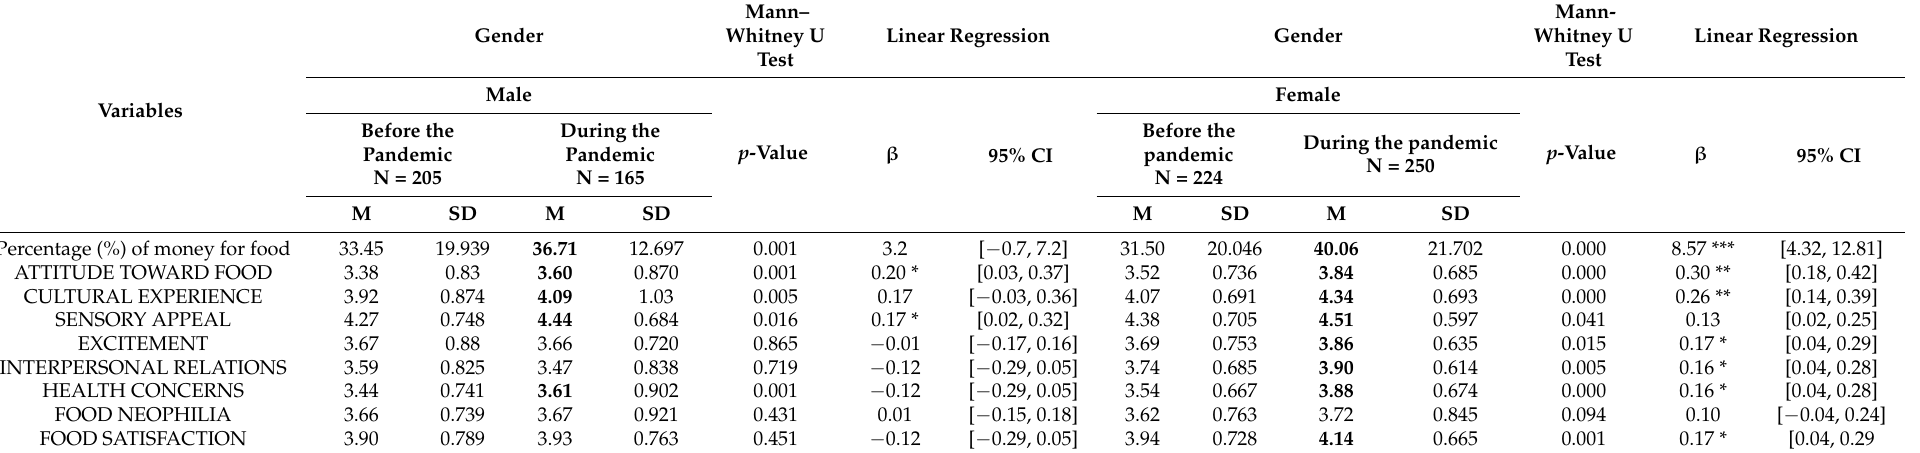
Table 9. The pandemic’s effect on money spent on food, food attitude, motivations, and satisfaction.